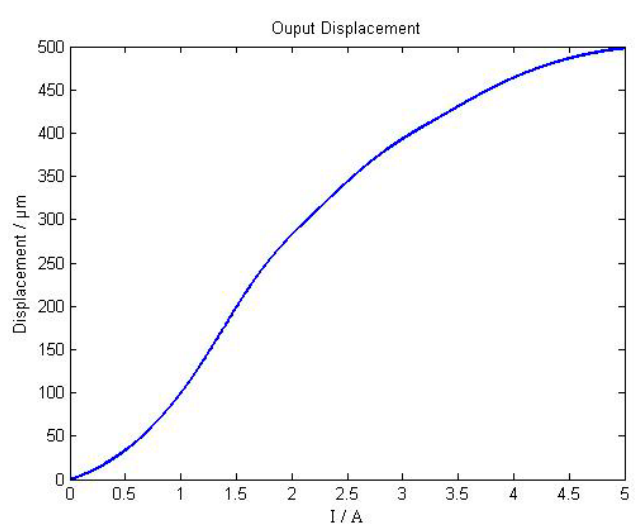
Figure 7. Axial output displacement curve of giant magnetostrictive actuator.